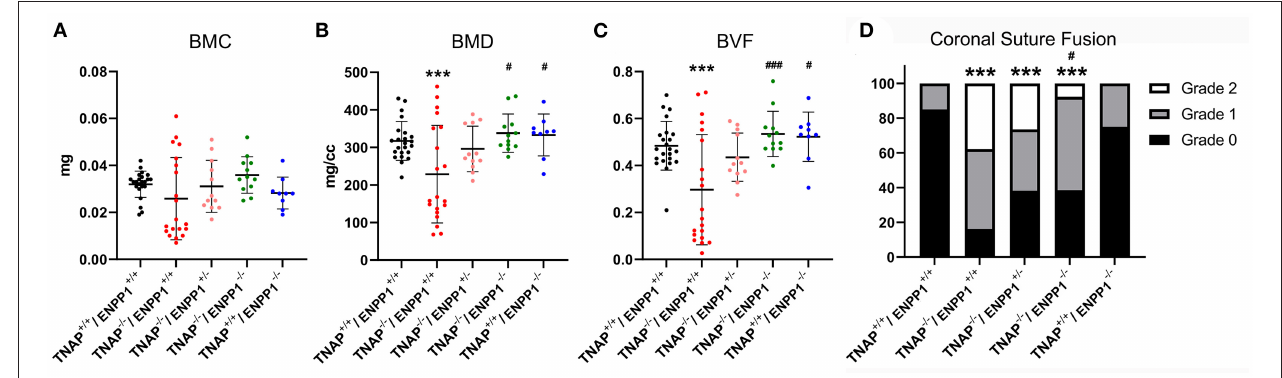
FIGURE 4 | TNAP and ENPP1 ablation effects on cranial bone mineralization and coronal suture synostosis. Bone mineral content (BMC), bone mineral density (BMD) and bone volume fraction (BVF) of the frontal cranial bone is shown (A–C) . TNAP − / − /ENPP1 + / + mice exhibit significantly diminished BMD and BVF when compared to TNAP + / + /ENPP1 + / + mice. TNAP − / − /ENPP1 − / − mice show significantly greater BMD and BVF than TNAP − / − /ENPP1 + / + mice, and are similar to values seen in TNAP + / + /ENPP1 + / + mice. (D) Coronal suture status was scored as 0 (normal suture anatomy), 1 (diminished width of suture/greater overlap of frontal and parietal bones) or 2 (suture fusion). TNAP − / − /ENPP1 + / + , TNAP − / − /ENPP1 + / − , and TNAP − / − /ENPP1 − / − mice all exhibit some incidence of coronal suture fusion while no coronal suture fusion is seen in TNAP + / + /ENPP1 + / + mice. TNAP − / − /ENPP1 − / − mice exhibit a significantly diminished incidence of coronal suture fusion when compared to TNAP − / − /ENPP1 + / + mice. *** p < 0.005 vs. TNAP + / + /ENPP1 + / + mice, # p < 0.05 vs. TNAP − / − /ENPP1 + / + mice, ### p < 0.005 vs. TNAP − / − /ENPP1 + / + mice.